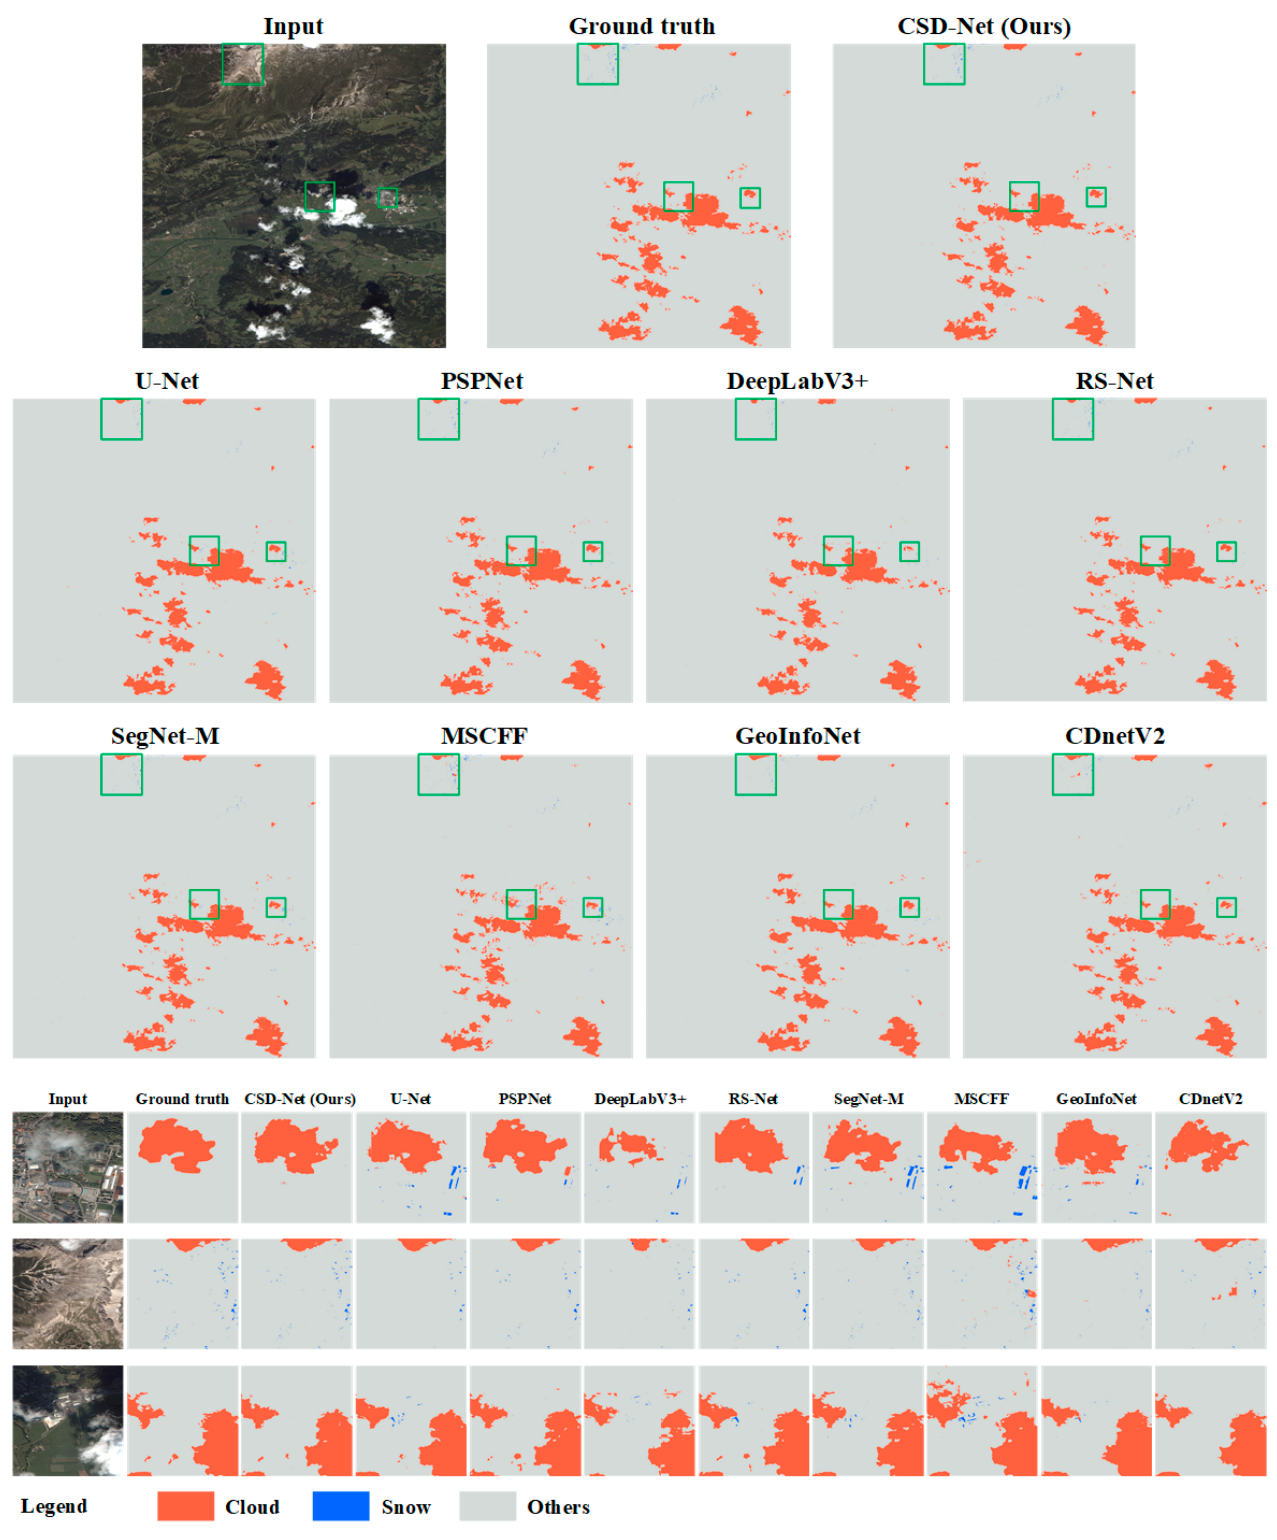
Figure 12. Large scene visualization of cloud and snow detection results by different methods based on the CSWV_S6 dataset. The delineated areas with the green boxes were magnified to provide a more detailed visual comparison in the bottom columns.